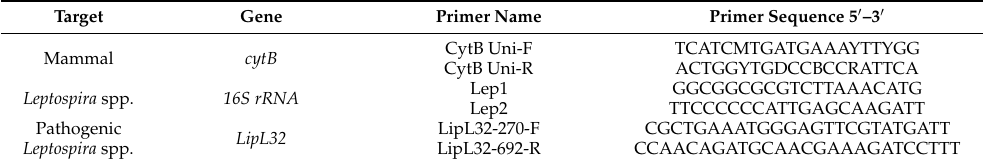
Table 1. Primers used for Leptospira spp.